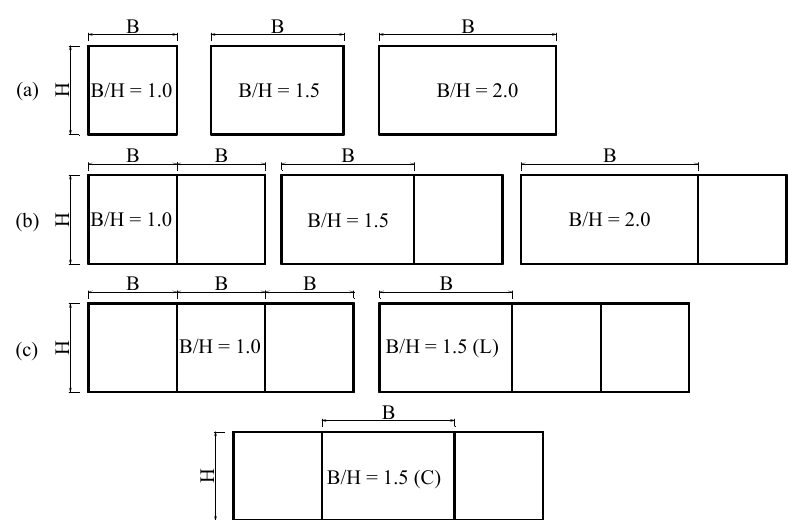
Figure 1. Sections of cut-and-cover box tunnels modeled: ( a ) Single, ( b ) double, and ( c ) triple boxes.